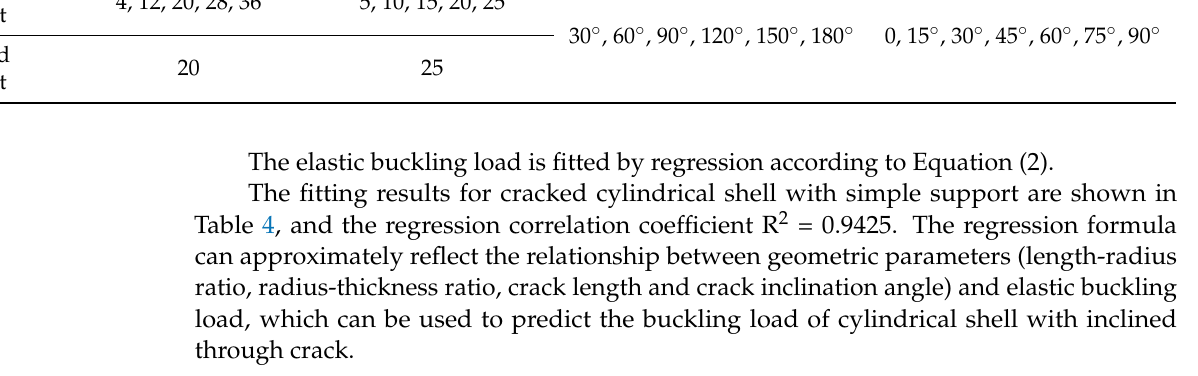
Table 4. Regression coefficients for cracked cylindrical shell with simple